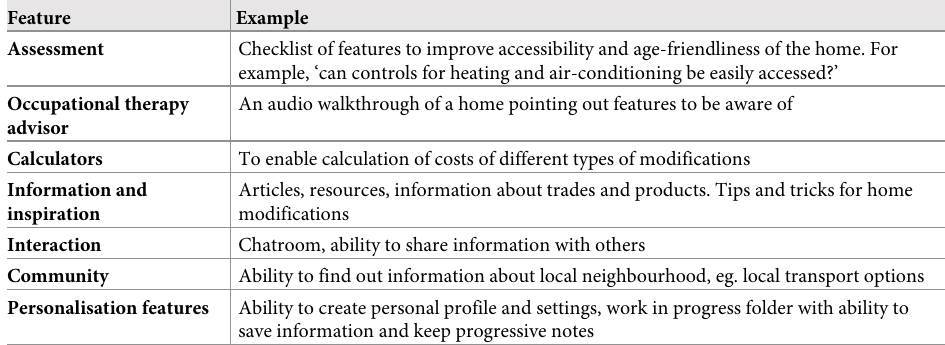
Table 1. Desirable features of a home assessment